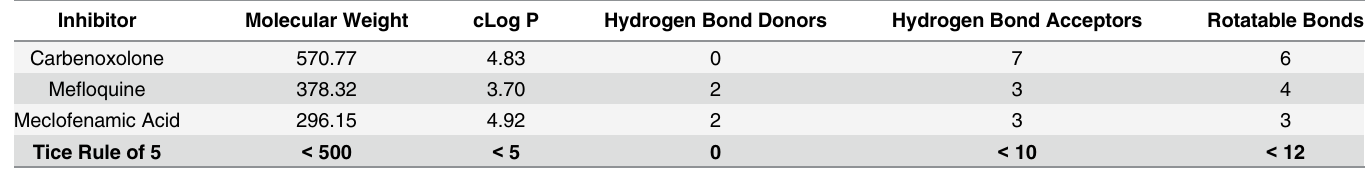
Table 3. Molecular properties of the gap junction inhibitors (rows 2 – 4) as compared to the properties identified by Tice [33] for screening for novel insecticides (row 5).